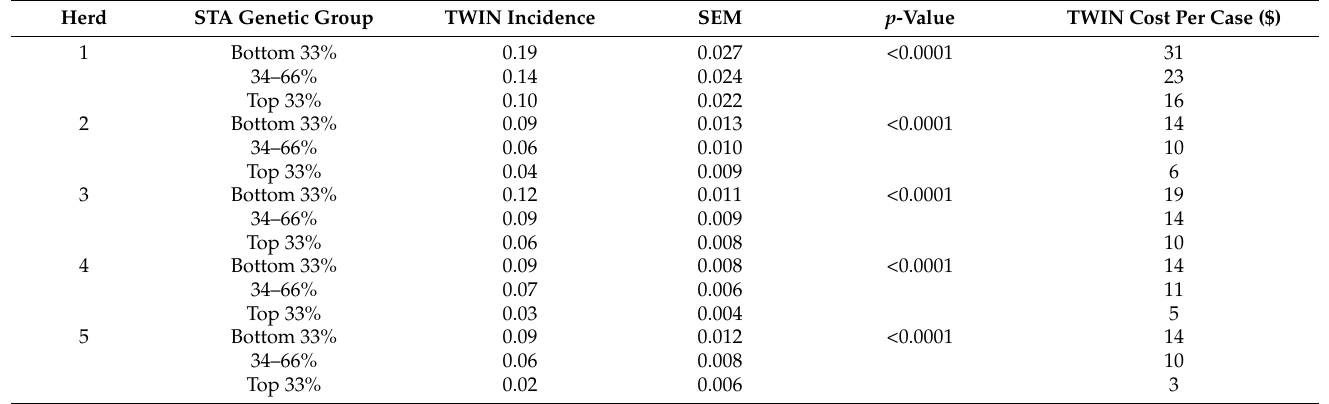
Table 8. Least squares means for TWIN STA genetic groups ( n = 3), TWIN incidence (marginal means), SEM of the genetic groups when animals are ranked by TWIN STA within herd, p -value, and estimated TWIN cost per case (i.e., cow) for each